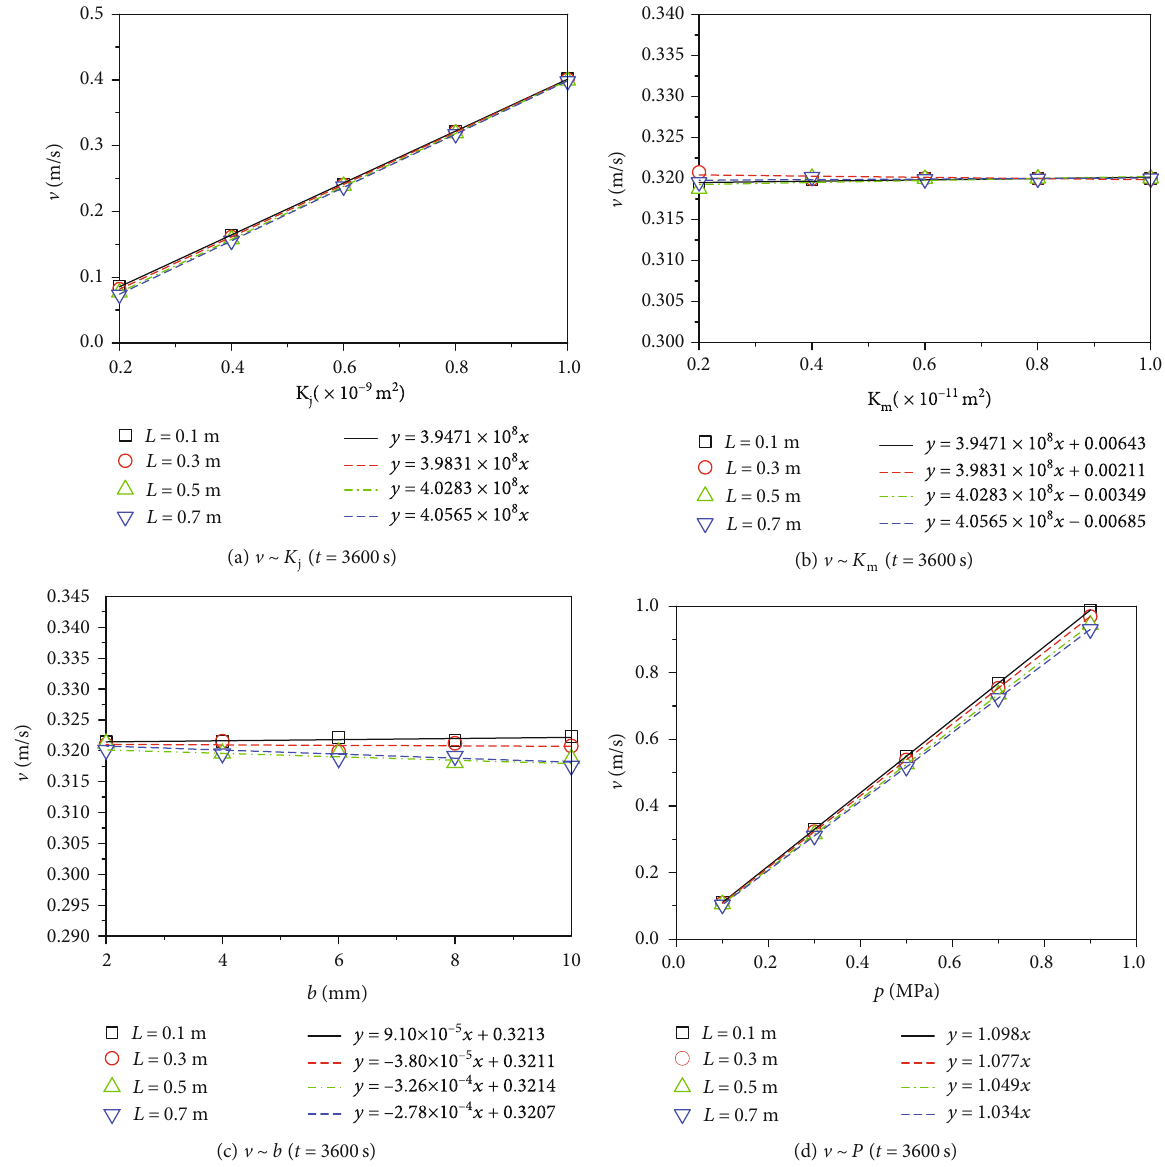
K b , P , and t j , m ,